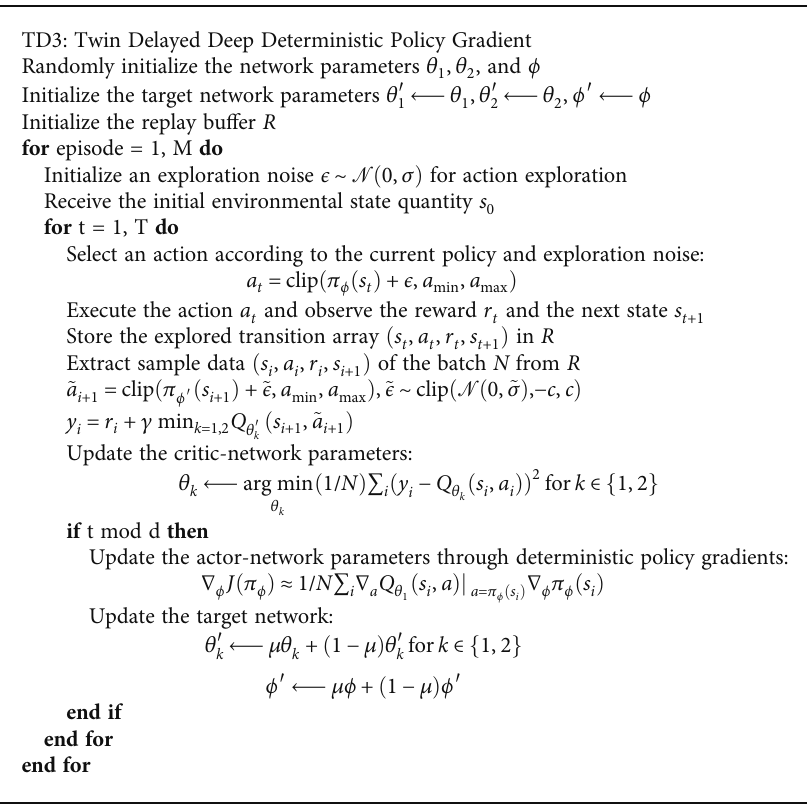
Algorithm 1: TD3 algorithm.